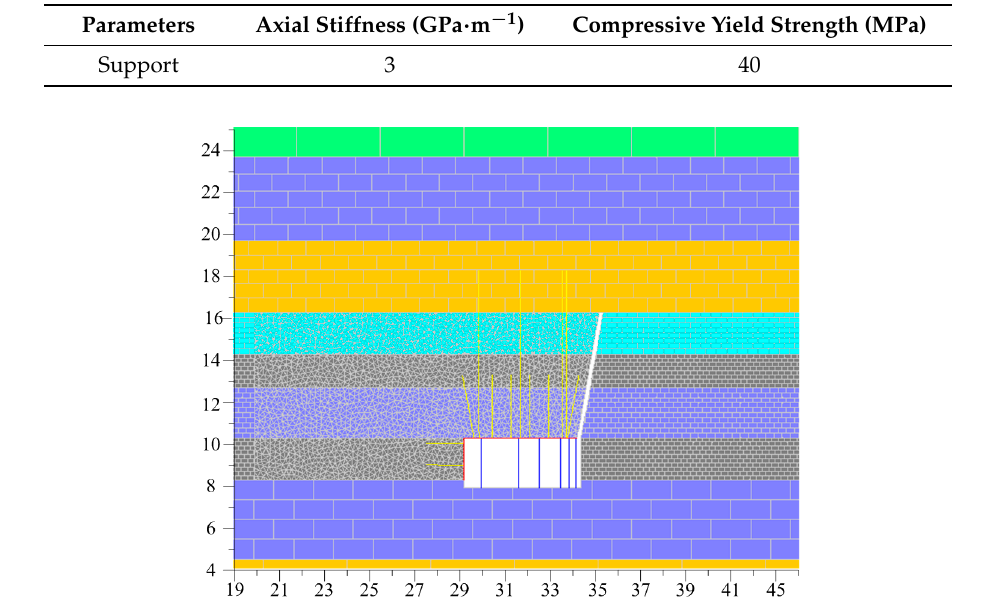
Figure 11. Numerical model of the gob-side entry in a supporting condition. Table 4. Properties of the bolt and cable elements used in the UDEC.